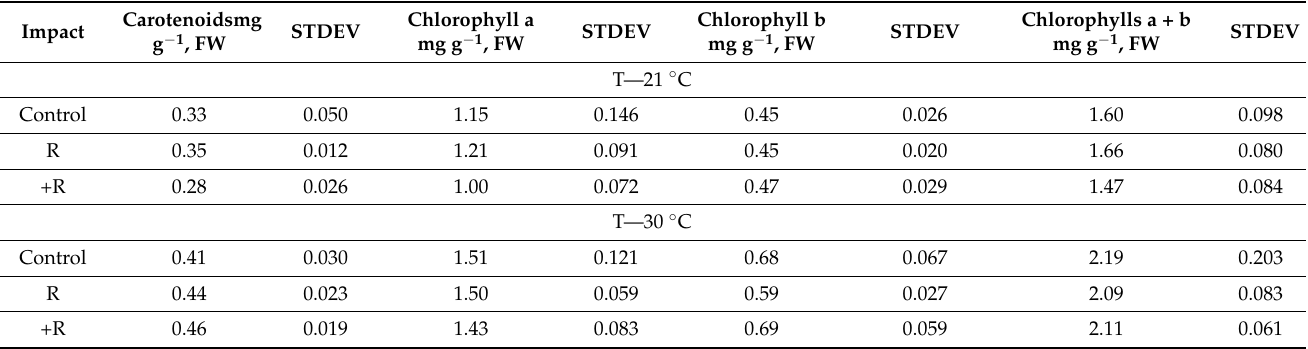
Table 2. Photosynthetic pigment amounts of tomato cultivated under combinations of different temperature and HPM radiation.